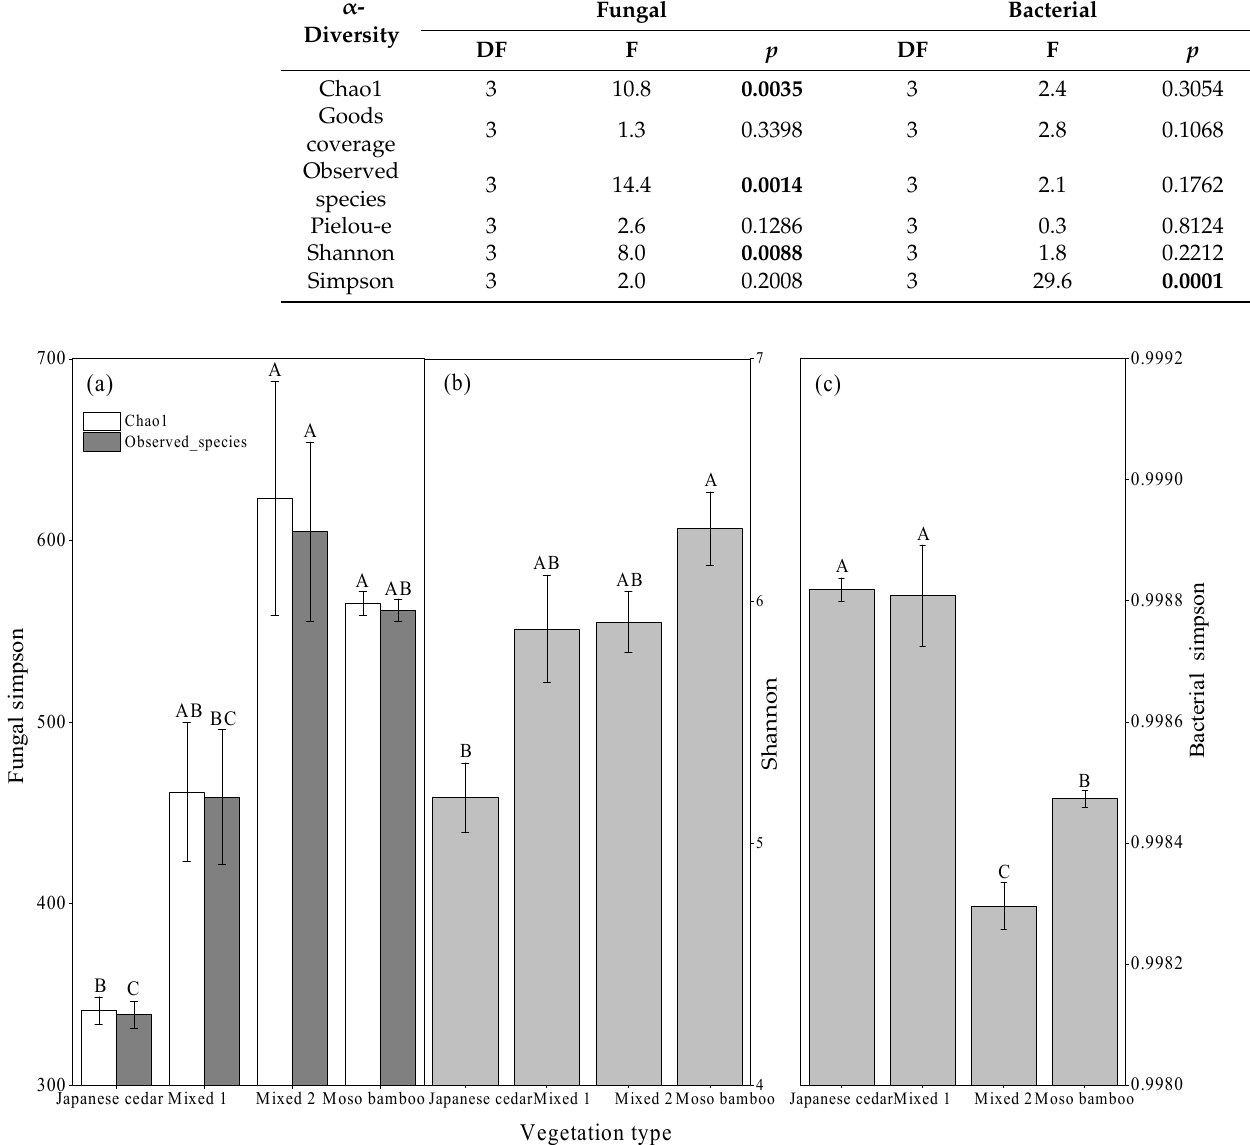
Figure 2. Effect of different vegetation types on soil fungal and bacterial α-diversity index (means ± se). ( a ) Fungal a diversity Chao1 and observed species index, ( b ) fungal a diversity Shannon index, ( c ) bacterial a diversity Simpson index. Different letters above columns in the same color indicate significantly different.